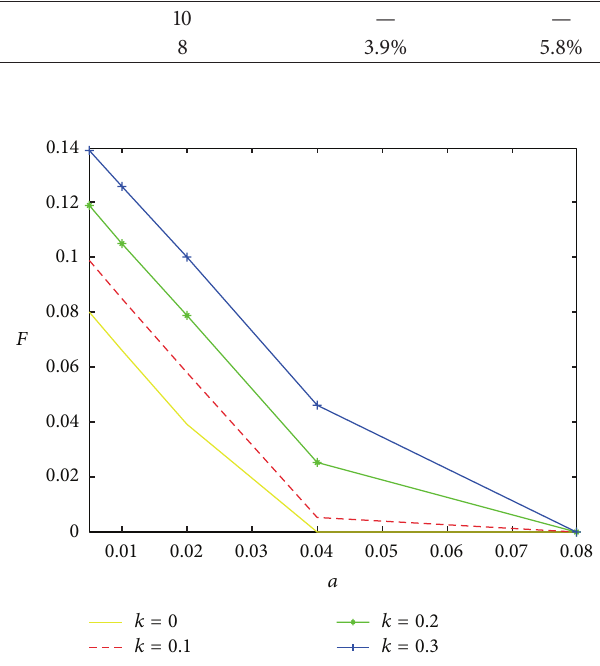
Figure 4: Impact of 𝑎 on sampling